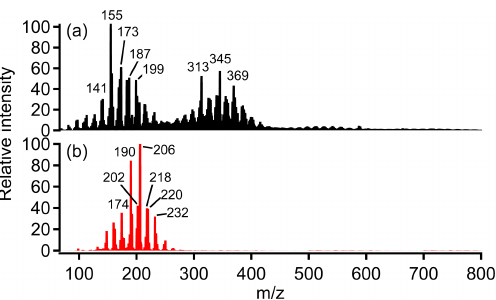
Figure 5. Mass spectra of SOA from ozone reaction with α -pinene under dry conditions (RH < 5%) obtained with (a) full scan and (b) neutral loss scan of